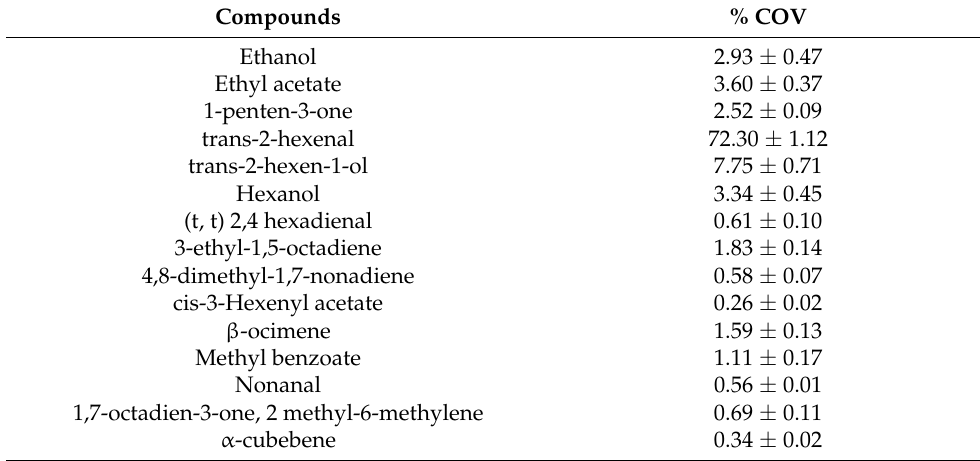
Table 5. Volatile organic compounds of olive oil of cultivar “Oliva Bianca” oil. The parameters are reported as means ± SD of three different replicates ( n =